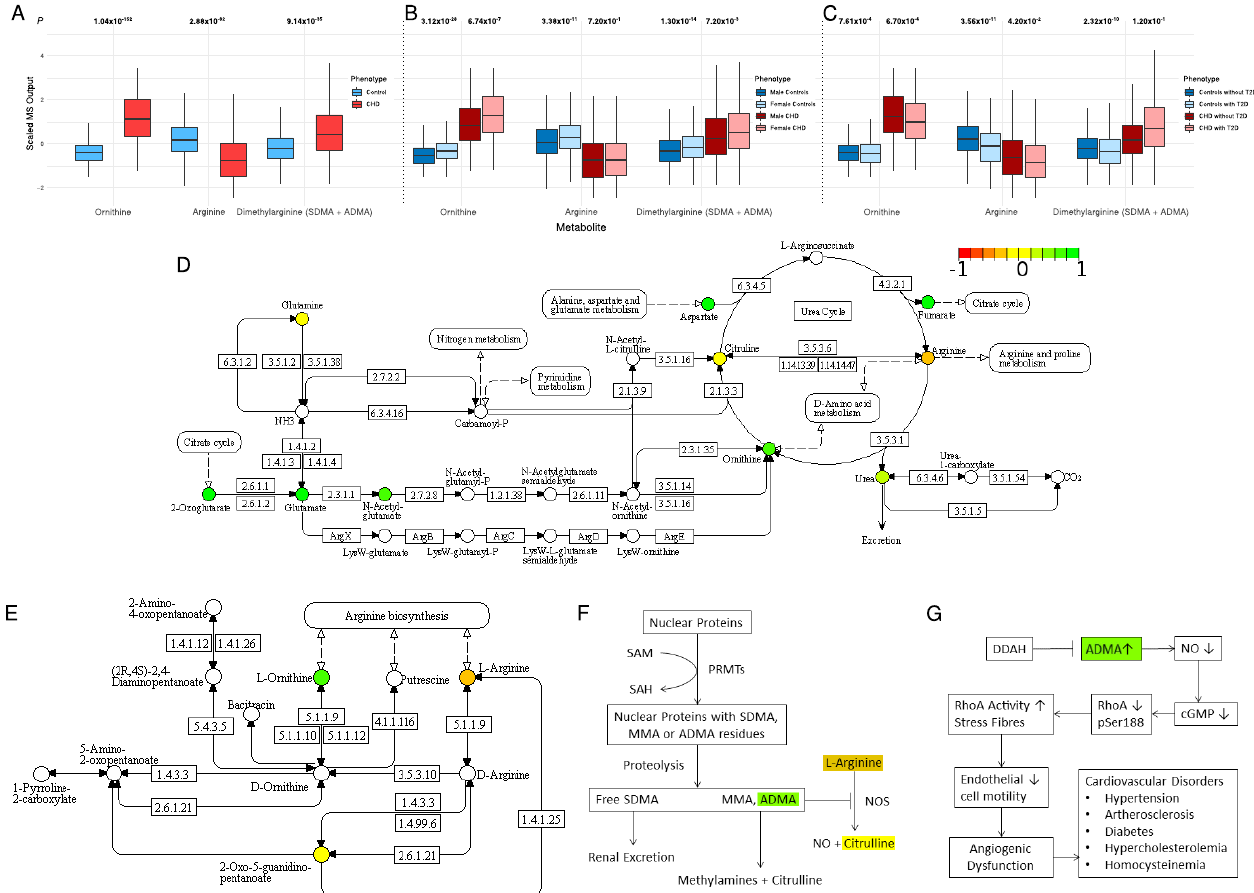
Figure 2. ( A ) The distribution of ornithine, arginine, and dimethylarginine in CHD patients